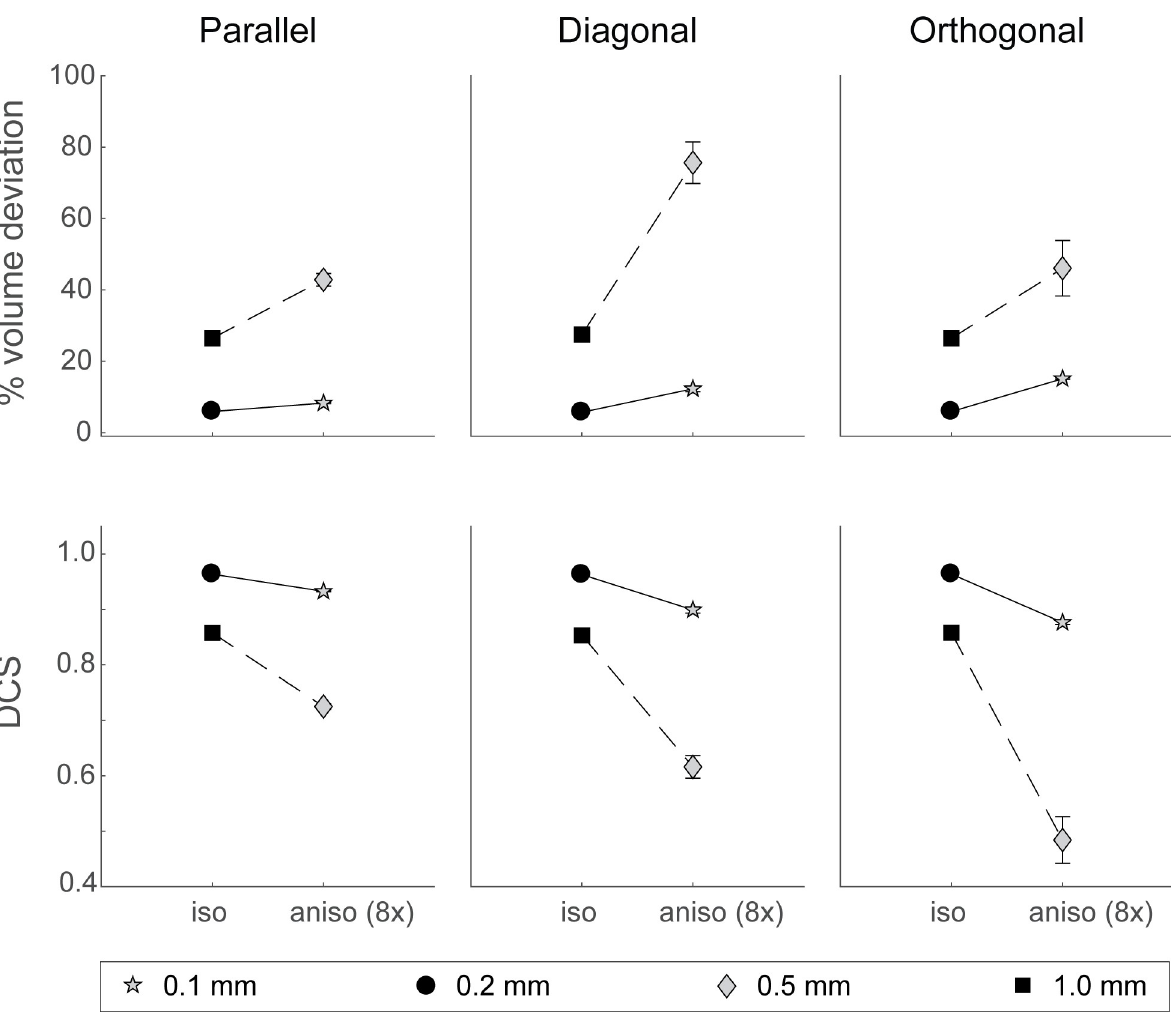
Fig 6. Effects of anisotropy. Comparison between volume and DCS for isotropic (0.2 x 0.2 x 0.2mm and 1.0 x 1.0 x 1.0mm) and anisotropic (0.1 x 0.1 x 0.8mm and 0.5 x 0.5 x 4.0mm) voxels of the same volume, labeled by the joint rater. Horizontal panels reflect orientations. Error bars indicate standard deviations from the